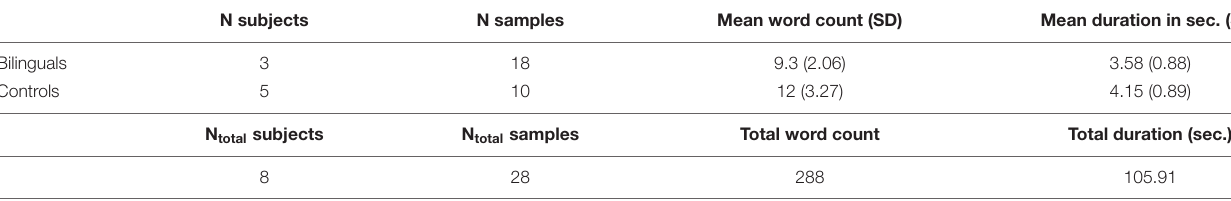
TABLE 1 | Overview of speakers and speech